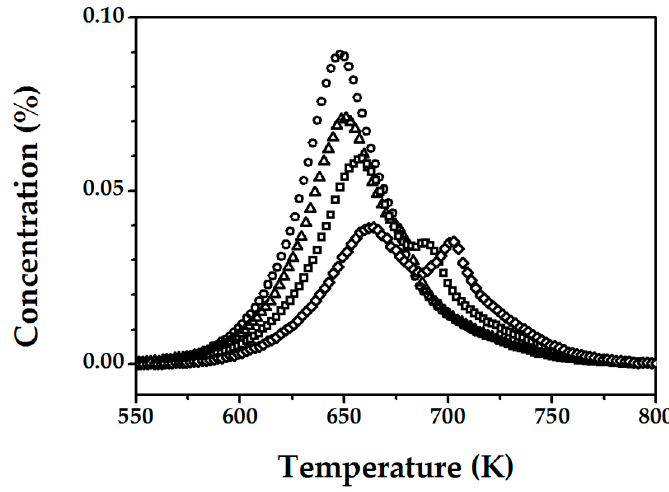
Figure 3. O 2 -TPD profiles for FeZSM-5 1200Fe activated in He at 1273 K for 1 ( ), 3 ( ), 5 ( ) and 15 h